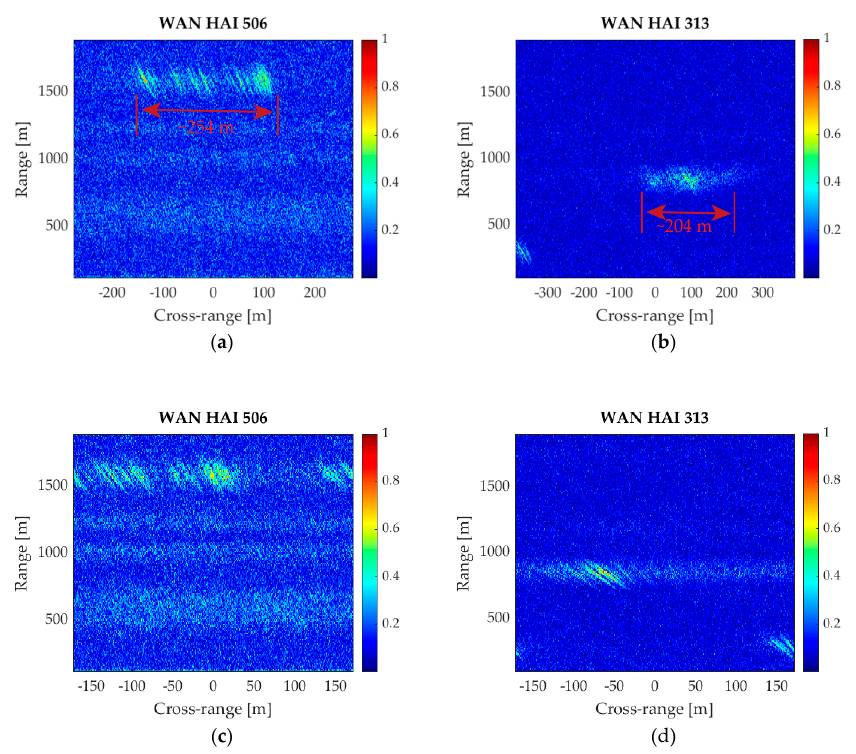
Figure 14. Synthetic aperture radar (SAR) images of two cargo ships with different velocities: ( a ) is WAN HAI 506 with the estimated velocity in Table 4, ( b ) is WAN HAI 313 with the estimated velocity in Table 4, ( c ) is WAN HAI 506 with target’s velocity = 3 m/s, and ( d ) is WAN HAI 313 with target’s velocity = 3 m/s.